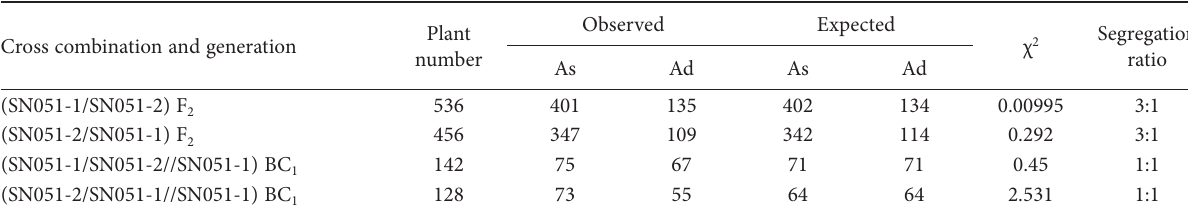
Table 1. Segregation for long awn or short awn in F 2 populations derived from F 1 of SN051-1 × SN051-2.